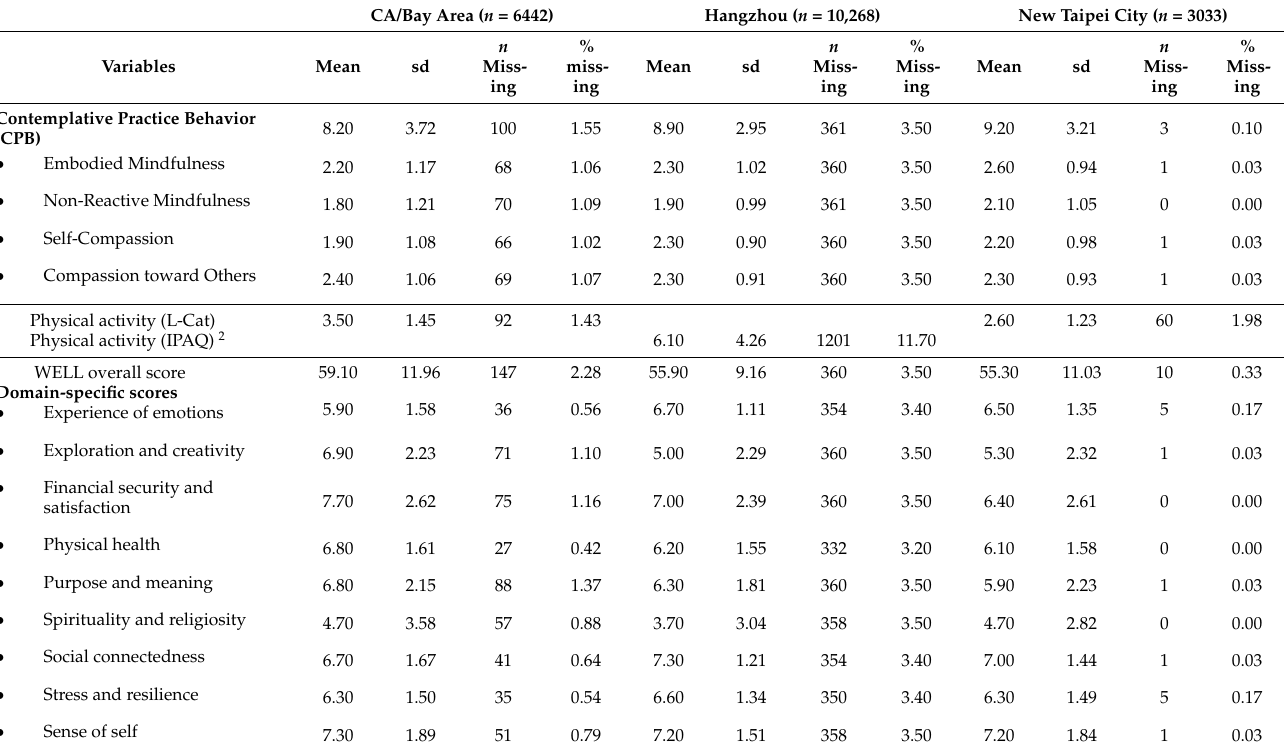
Table 3. Health Behaviors and Well-Being Outcomes across the Study Sample 1 . CA/Bay Area ( n = 6442) Hangzhou ( n = 10,268)